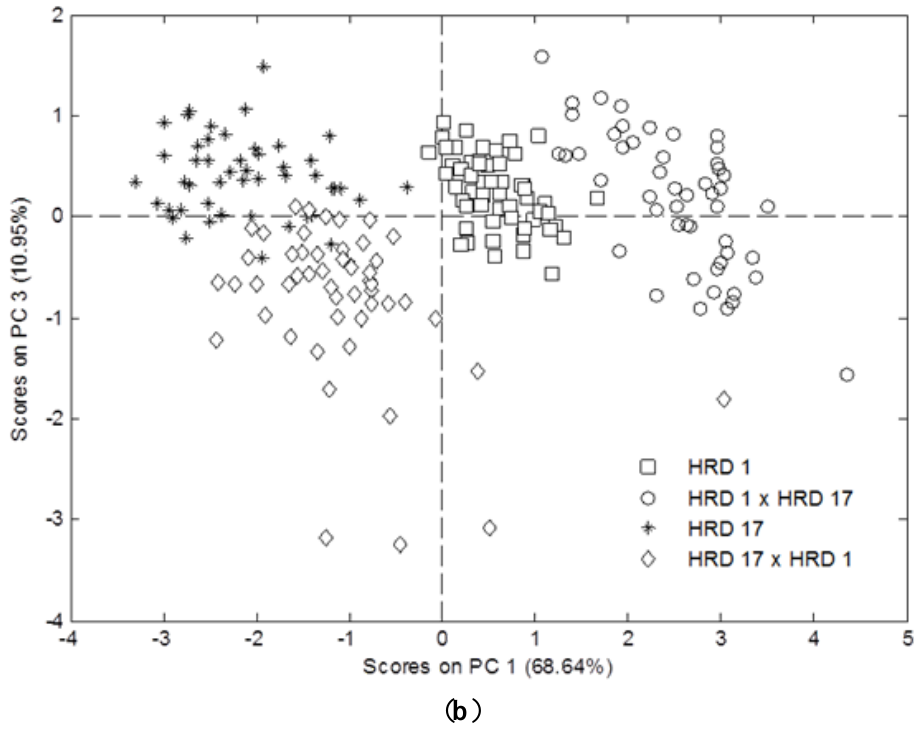
Figure 2. Discrimination of parent and their crosses by ( a ) nCDA; ( b ) PCA on blob dataset.